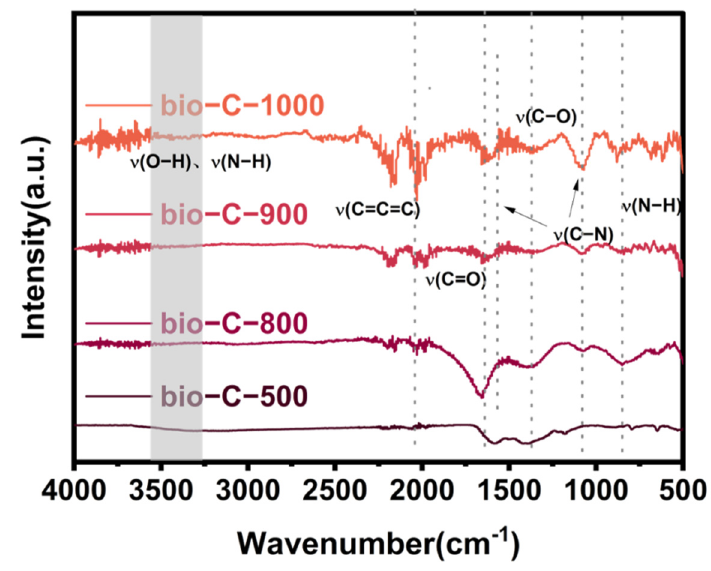
Figure 4. Fourier transform infrared (FTIR) spectrum of IISERP − MOF − 27 − derived carbon which is pyrolyzed at temperatures ranging from 500 °C to 1000 °C.